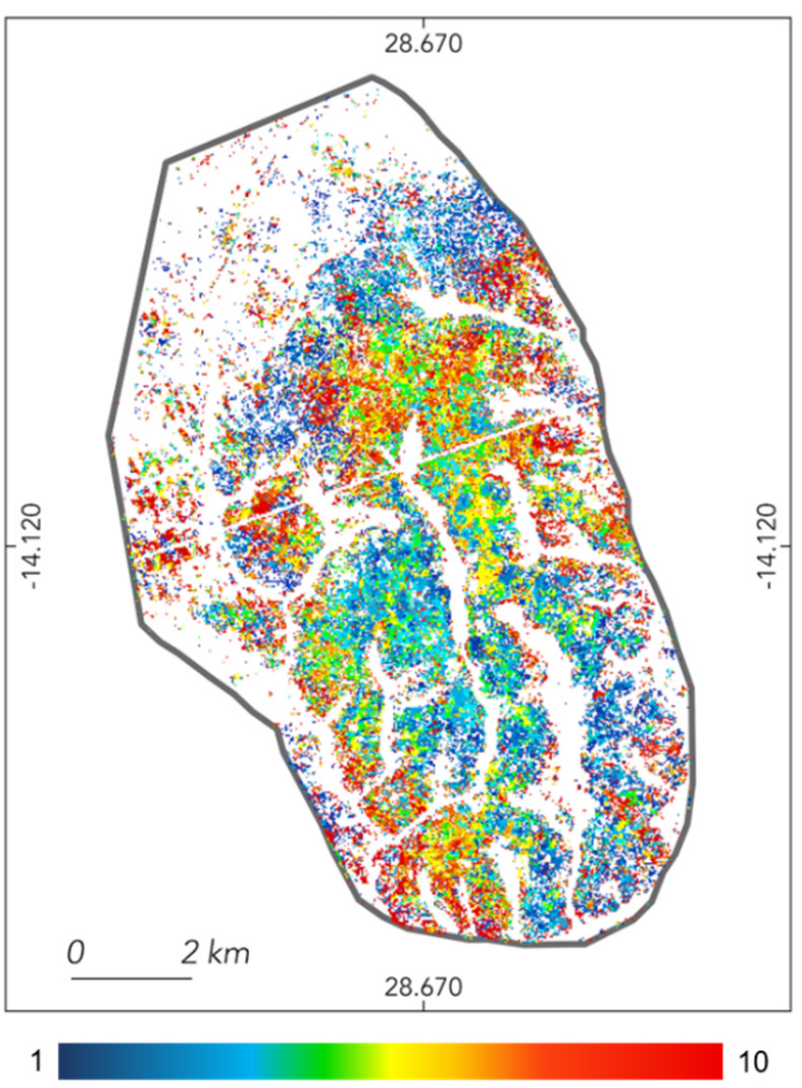
Figure 10. Map of number of years between charcoal production and cultivation in Kapiri Mposhi forest reserve.